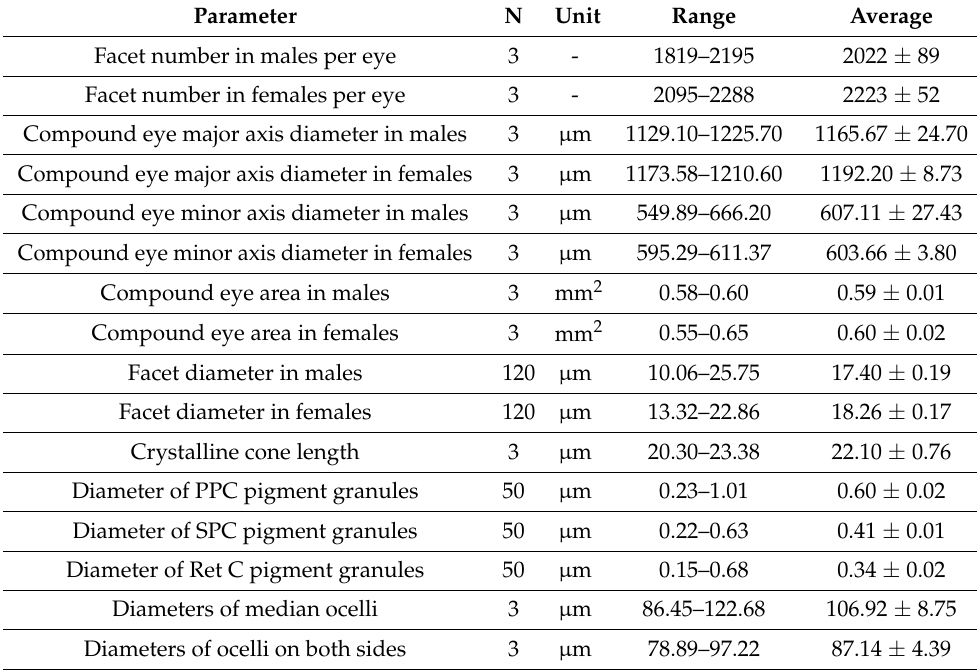
Table 1. Morphological and histological details of the compound eyes in Arge similis . Number of samples (N), range, and averages (mean ± SE) are given in connection with each measurement. Parameter N Unit Range Facet number in males per